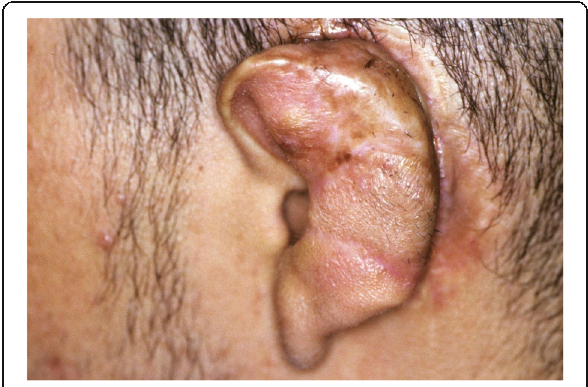
Fig. 2 Left auricle, post-reconstruction